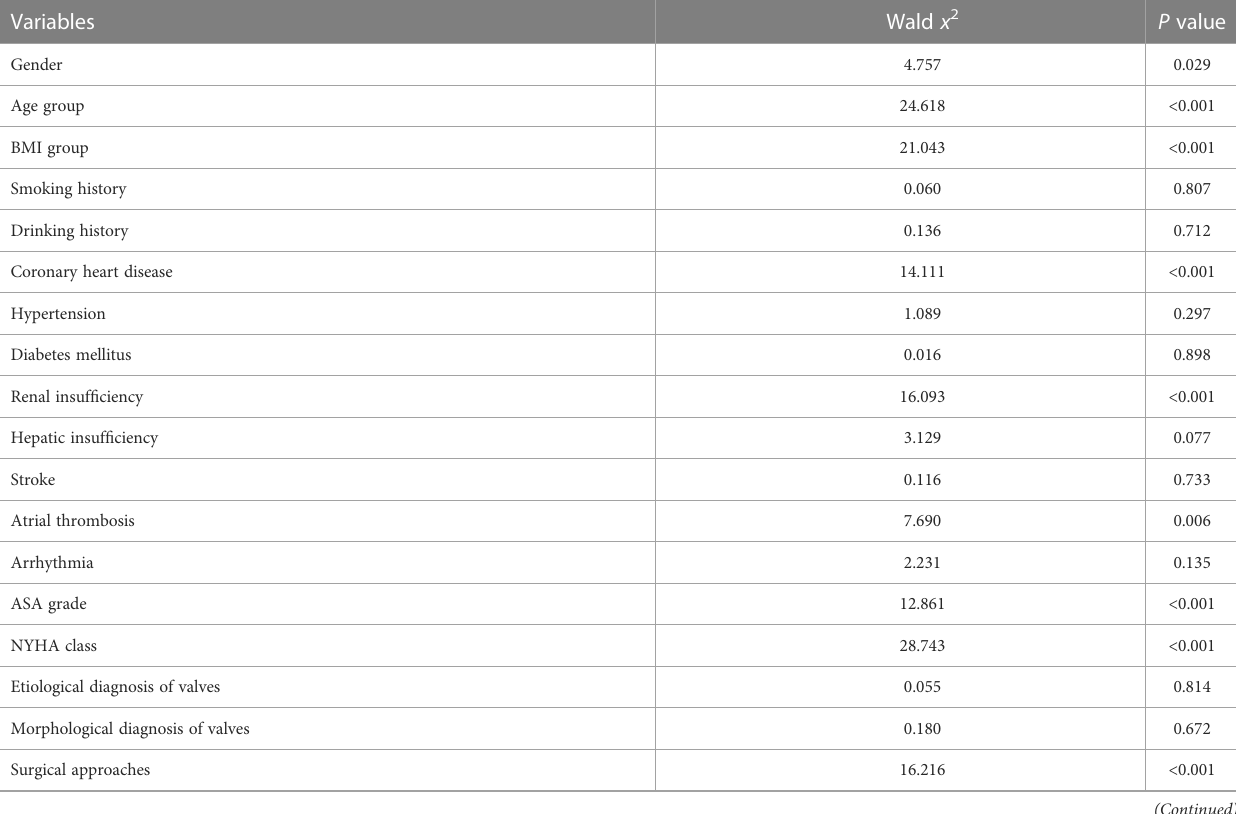
TABLE 4 Univariable analysis for death within 30 days after surgery.